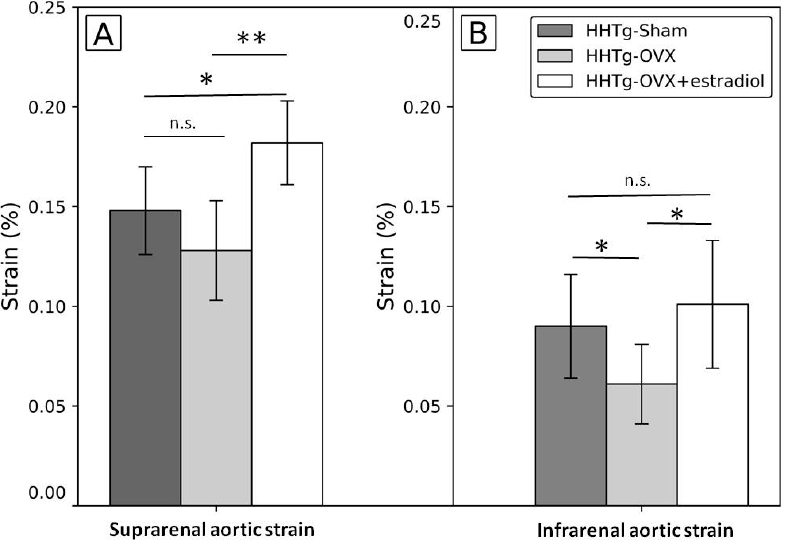
Figure 1. Differences in the strain of the abdominal aorta after ovariectomy and estradiol substitution in HHTg rats in suprarenal ( A ) and infrarenal ( B ) segments. Legend: Strain: (systolic-diastolic aortic diameter)/diastolic aortic diameter; HHTg: hereditary hypetriglyceridemic; HHTg-Sham: sham group, n = 5; HHTg-OVX: Ovx: ovariectomy ( n = 6); HHTg-OVX + estradiol: ovariectomy followed